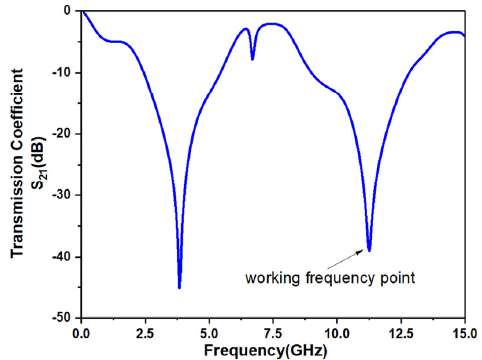
Figure 3. Simulation result of sensor without MUT loaded.